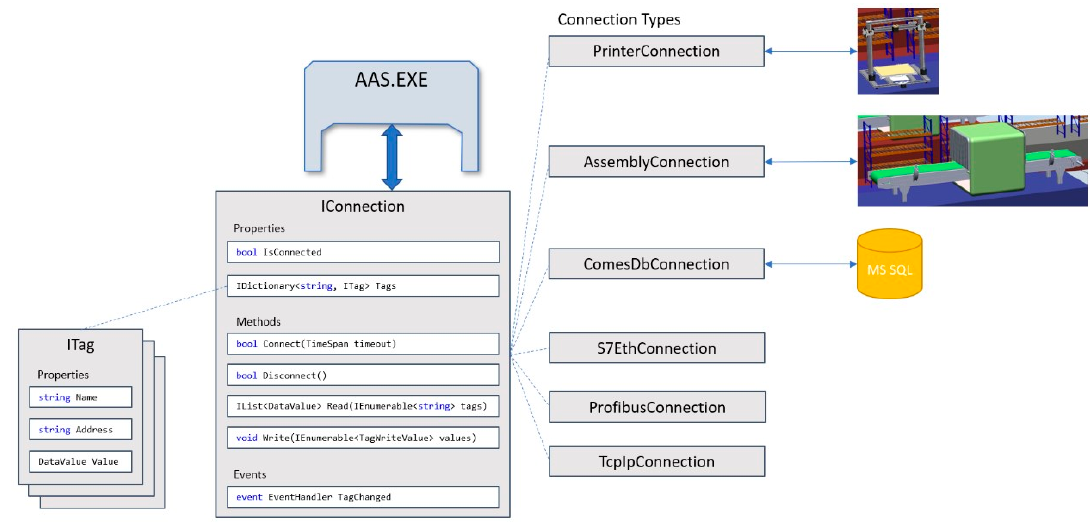
Figure 11. Integration of different communication drivers without rebuilding the AAS.